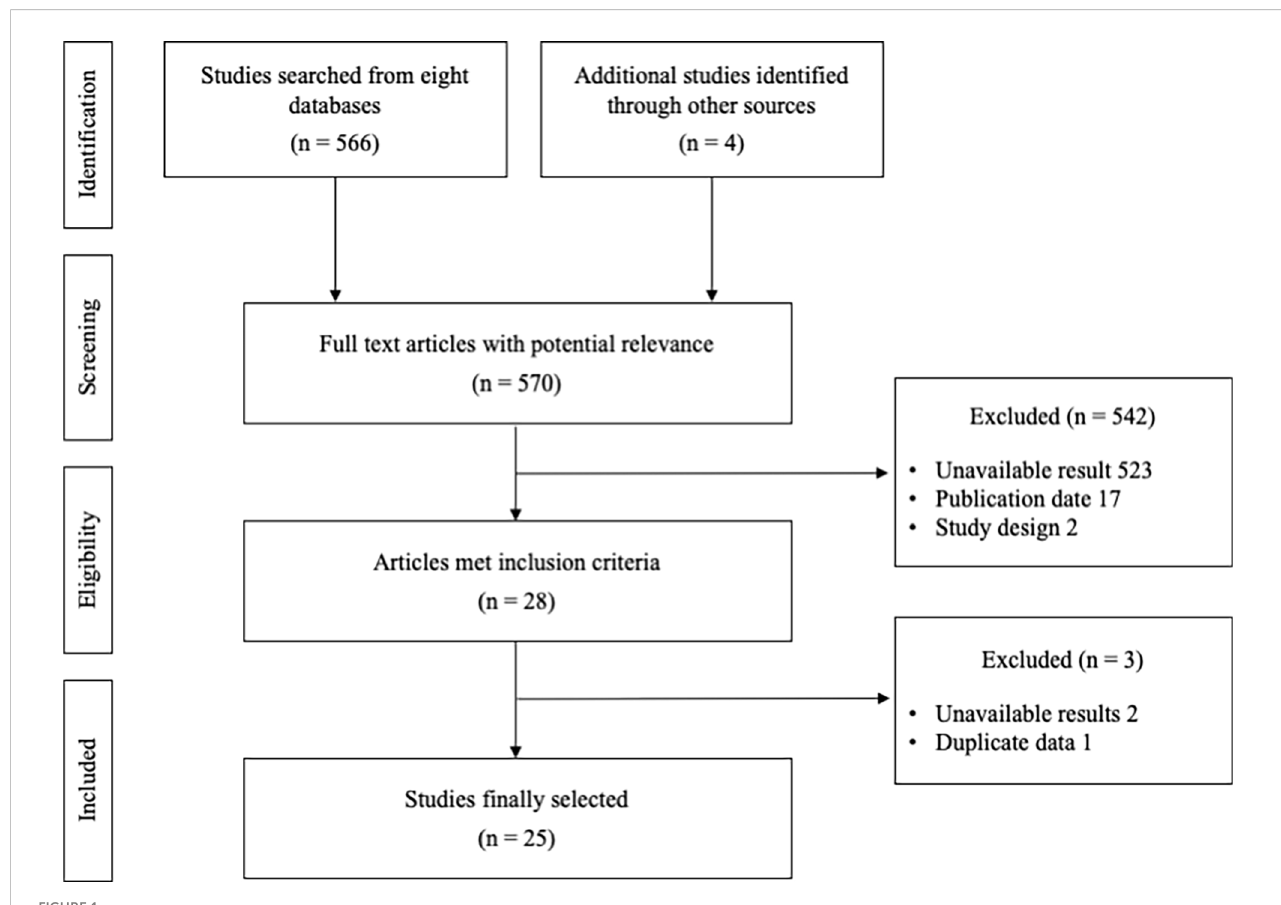
FIGURE 1 Flow diagram of study selection